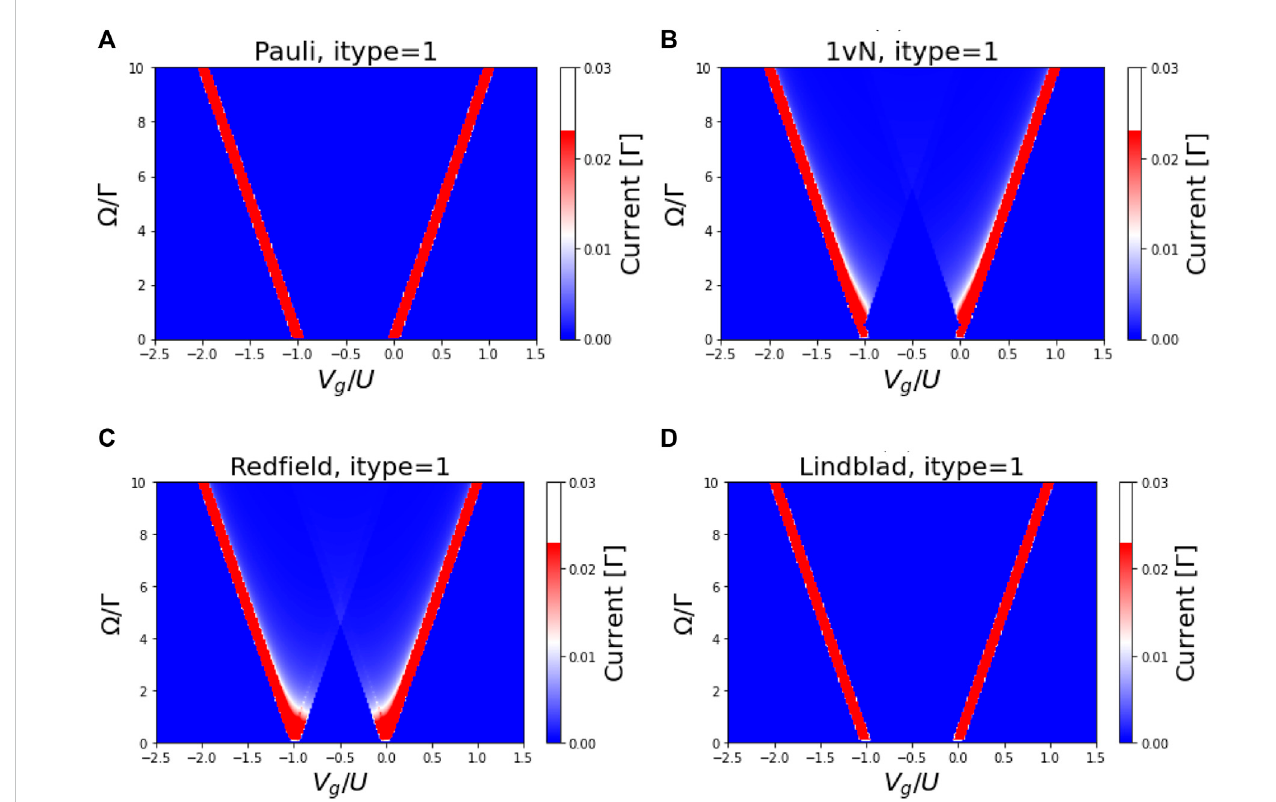
FIGURE 6 Performance of Pauli (A) , fi rst order von Neuman (B) , Red fi eld (C) and Lindblad (D) quantum master equations in the spinful single orbital quantum dot model showing the dependence of the tunneling current on gate voltage and strength of the orbital